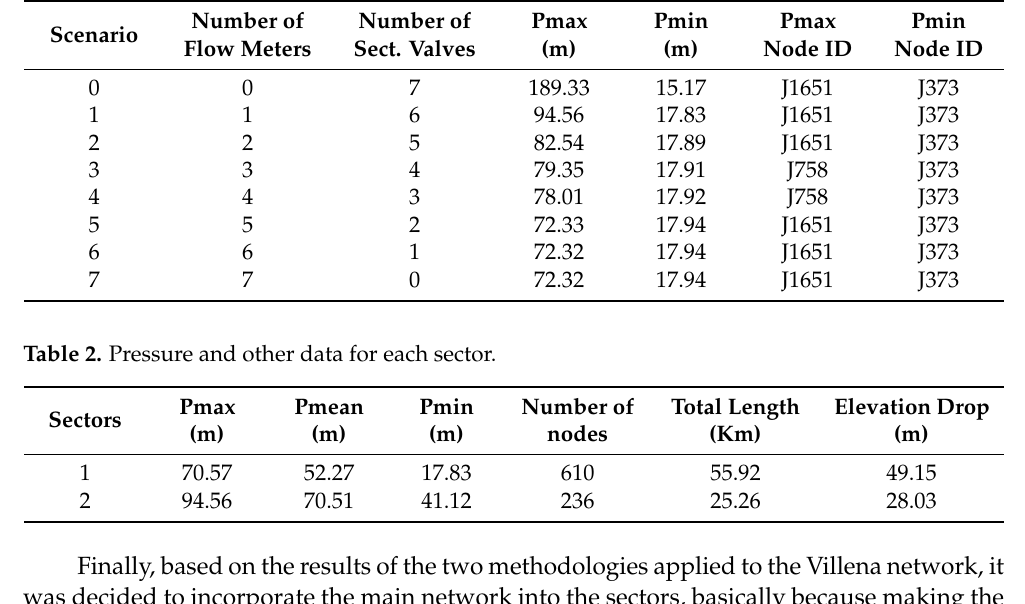
Figure 2. Villena’s network sectorization. ( a ) Flow paths, ( b ) sectors by main network, ( c ) sectors by source contributions, ( d ) sectors based on the minimum hydraulic resistance tree. Table 1. Villena network, maximum, and minimum pressure for each scenario applying the second methodology.